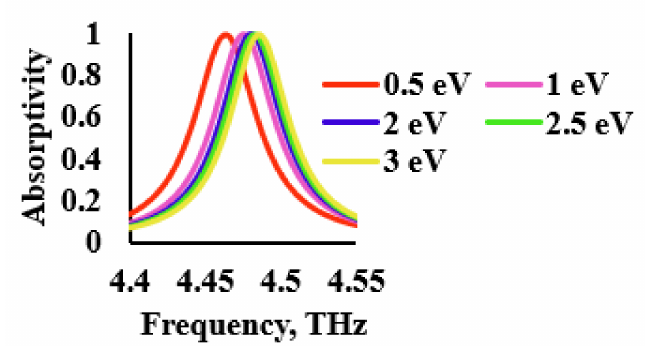
Figure 10. Sensor performance for varying graphene chemical